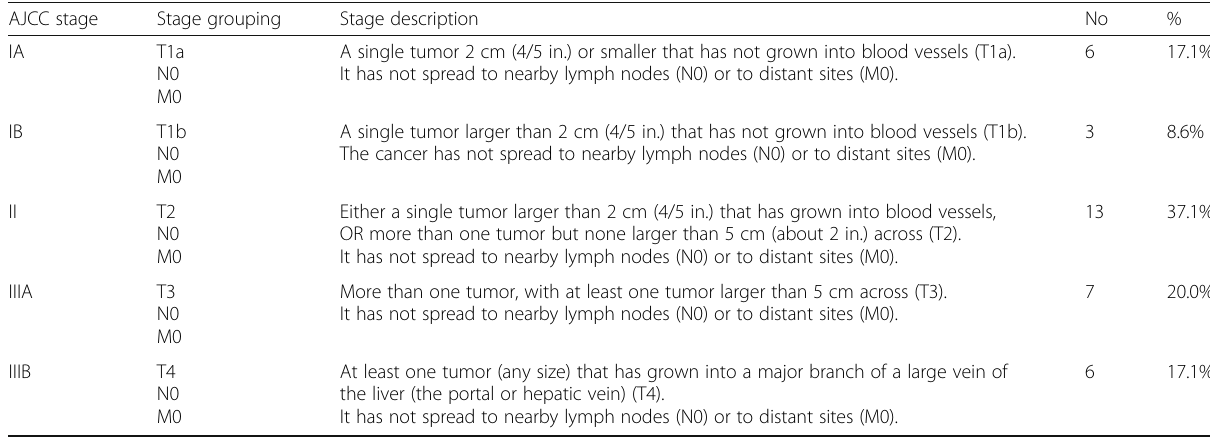
Table 7 Distribution of stages of tumors in HCC group according to the AJCC AJCC stage Stage